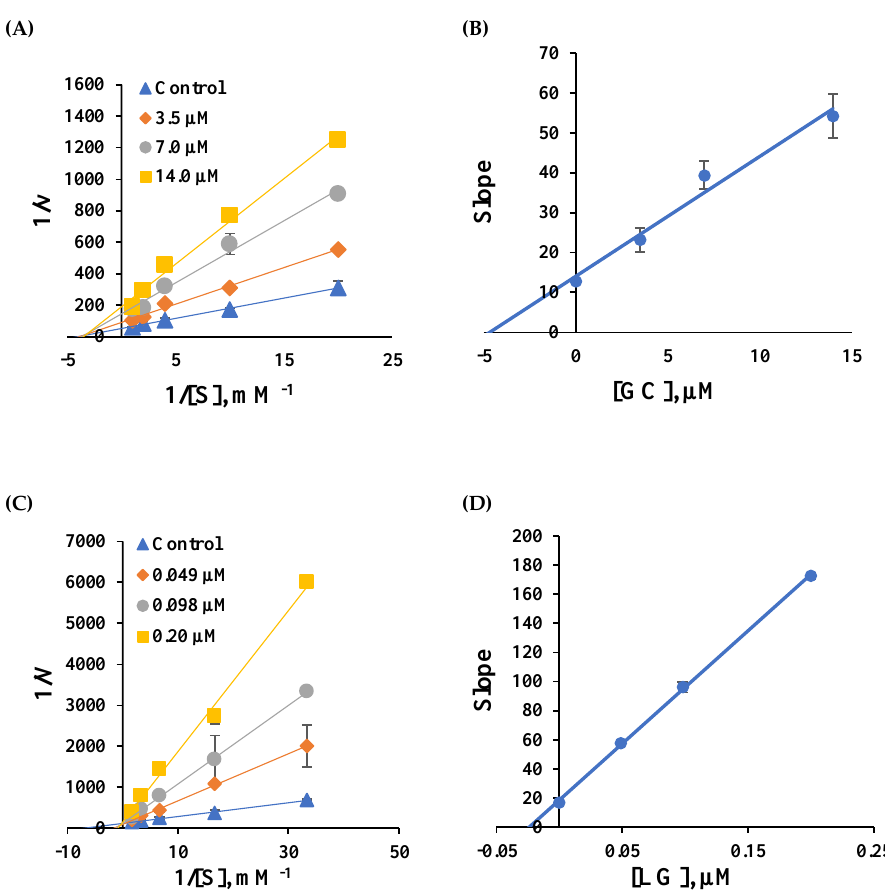
Figure 3. Lineweaver-Burk plots of inhibitions of BChE by GC ( A ) and of MAO-B by LG ( C ), and their respective secondary plots ( B , D ) of slopes of Lineweaver-Burk plots versus inhibitor concentrations. Five di ff erent substrate concentrations were used; 0.05, 0.1, 0.25, 0.5 or 1.0 mM for BChE, and 0.03, 0.06, 0.15, 0.3, or 0.6 mM for MAO-B. Inhibition studies were carried out at three inhibitor concentrations, that is, at 0.5 × , 1.0 × , and 2.0 × of the IC 50 values of GC and LG. The errors were determined by duplicate experiments.